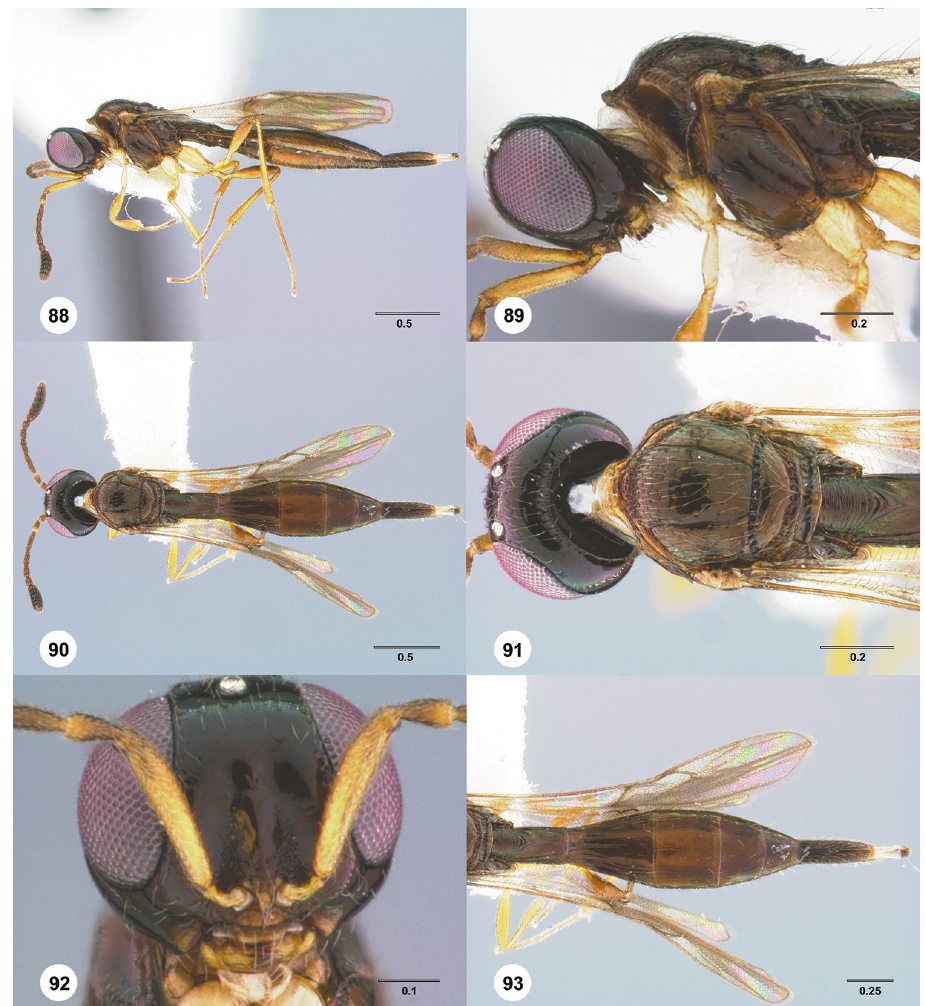
Figures 88–93. Calliscelio crena sp. n., female, holotype (OSUC 553462). 88 Lateral habitus 89 Head and mesosoma, lateral view 90 Dorsal habitus 91 Head and mesosoma, dorsal view 92 Head, anterior view 93 Metasoma, dorsal view. Scale bars in millimeters. Sculpture of frons below median ocellus: largely smooth with sparse fine punctures. Sculpture of posterior vertex: largely smooth with sparse fine punctures. Hyperoccipi- tal carina: absent. Occipital carina medially: complete, strongly crenulate throughout. Length of OOL: less than 0.5× ocellar diameter. Sculpture of postgena behind outer orbit: smooth. Ocular setae: absent. A4 in female: distinctly shorter than A3. A5 in female: shorter than A3, distinctly longer than wide. Shape of female A6: as long as wide. Form of male antennal flagellomeres: filiform, A11 approximately 2.0× longer than wide. Length of A5 tyloid in male: greater than 0.5× length of